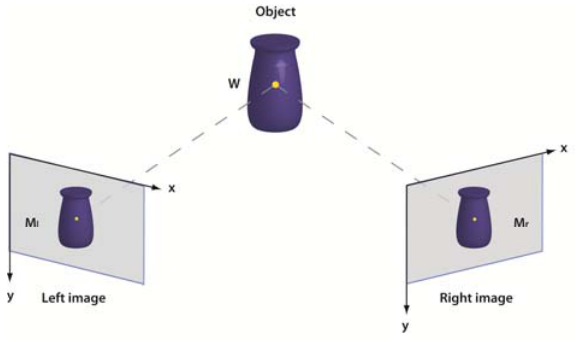
Figure 1: Stereo correspondence in left ( ml ) and right ( mr ) images of a 3D point w on the